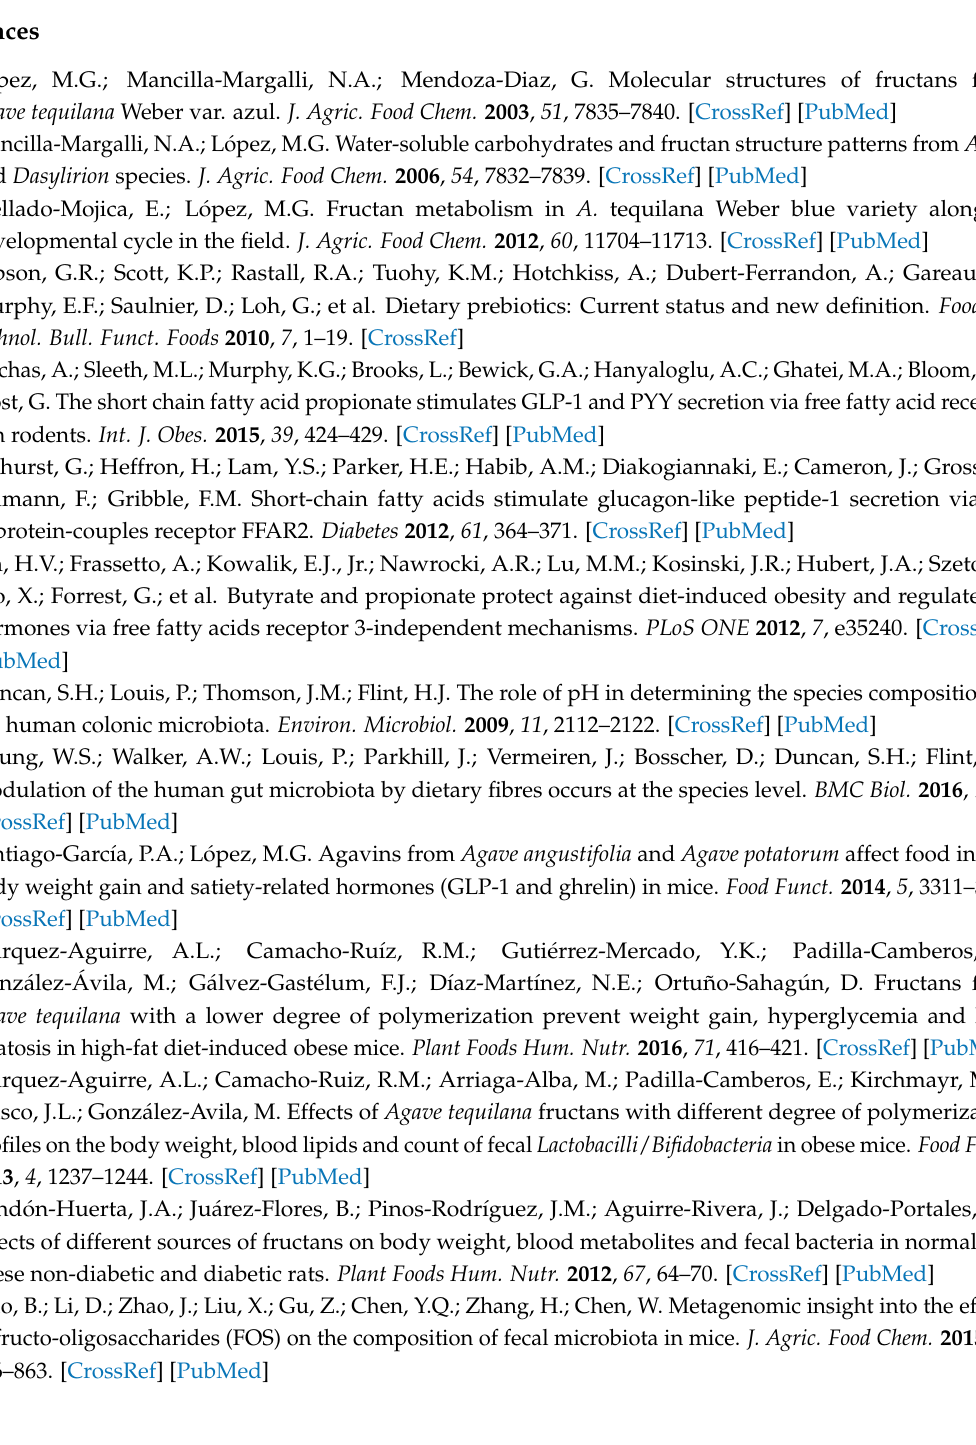
Table S1: Sequencing yield and operational taxonomic units obtained through MiSeq sequencing